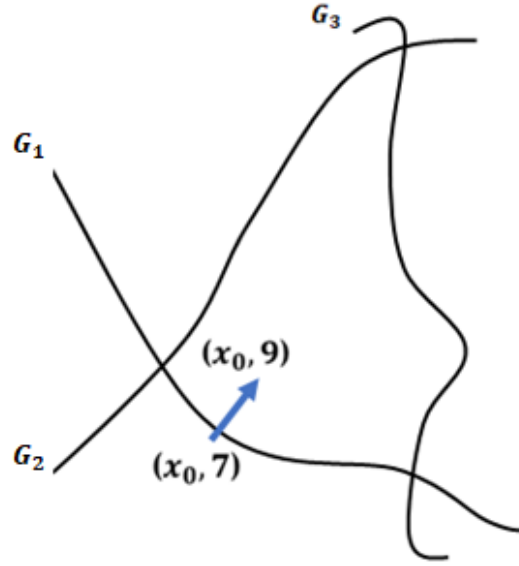
Figure 19. Hyperplane G i separates data points of different classes [122] by extending the distance between a point and a line in a 2D plane to the distance between the decision boundaries and classes on the hyperplane.